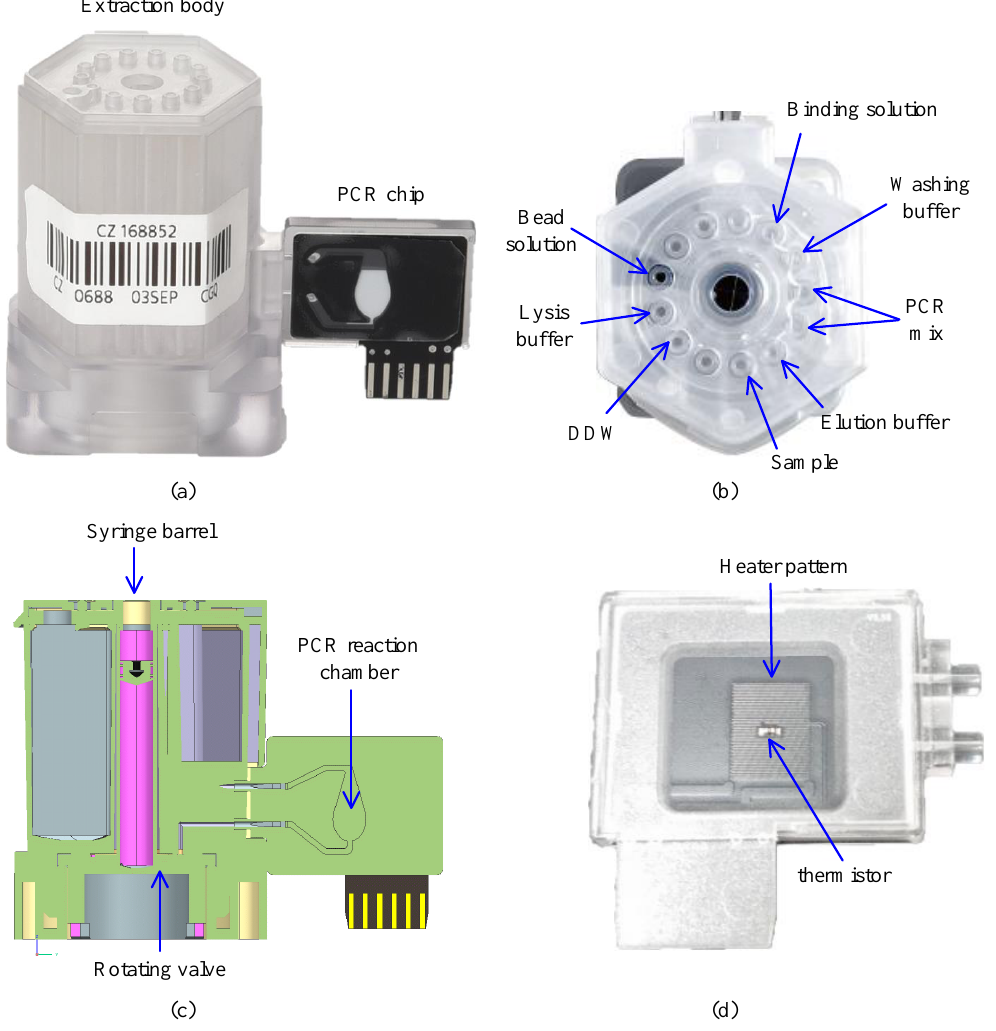
Figure 1. The actual cartridge used to demonstrate the performance of control with the proposed software. ( a ) Side view of the cartridge; ( b ) Top view of the extraction body showing an example of reagents allocation into each chamber; ( c ) Cross section illustration of the cartridge; ( d ) The back-side picture of the PCR chip which shows the heater pattern and thermistor attached to the PCB.